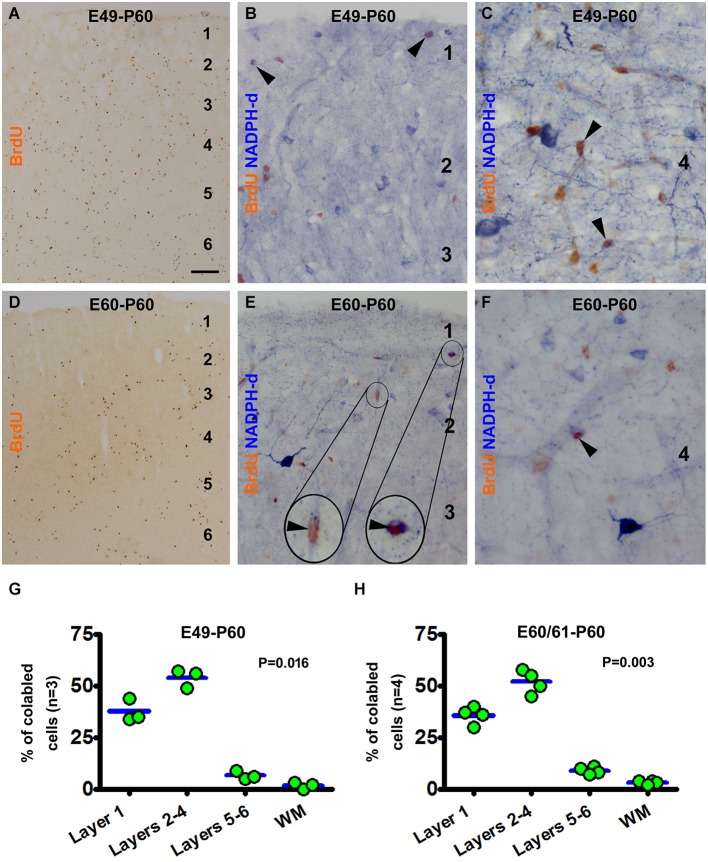
Examples of images and laminar quantifications for bromodeoxyuridine (BrdU) labeling and colocalization in type II NADPH-d neurons in 2 month-old guinea pigs following prenatal BrdU pulse-chasing. Shown are the E49-P60 (A–C,G) and E60-P60 (D–F,H) groups. BrdU immunoreactive cells are present across the cortex without apparent laminar preference in both groups, with noticeably less amount cells in the latter group (A,D). High magnification images illustrate BrdU colabeling in a few type II NADPH-d neurons (arrowheads and inserts) (B,C,E,F), with no colocalization in type I neurons. Over 50% and 30% of the colabeled type II cells occur in layers 2–4 and layer I, respectively for both groups (G,H). Scale bar = 100 μm in (A) applying to (D), equivalent to 20 μm for (B,E) and 10 μm for (C,F).